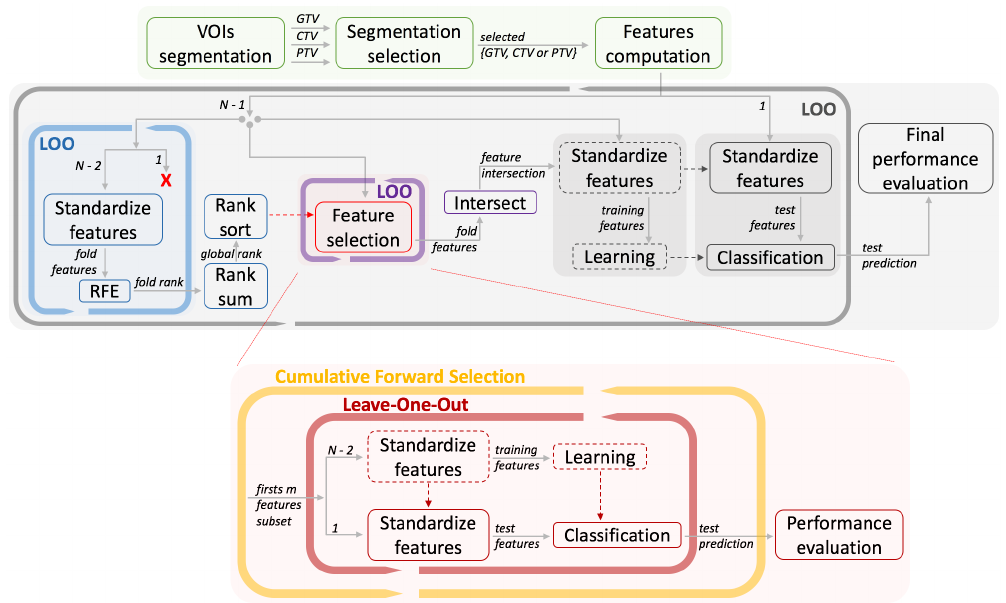
Figure 2. Graphical representation of the method, where the different colours refer to different steps pipeline described in Section 4. List of abbreviations: VOI: Volume of Interest, LOO: Leave-One-Out, RFE: Recursive Feature Elimination, N: number of patients, GTV: Gross Tumour Volume, CTV: Clinical Target Volume, PTV: Planning Target